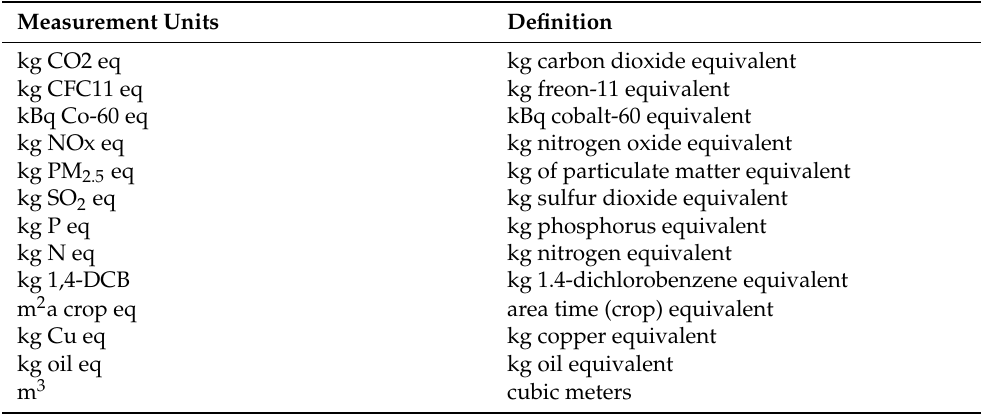
Table 1. Impact categories unit of